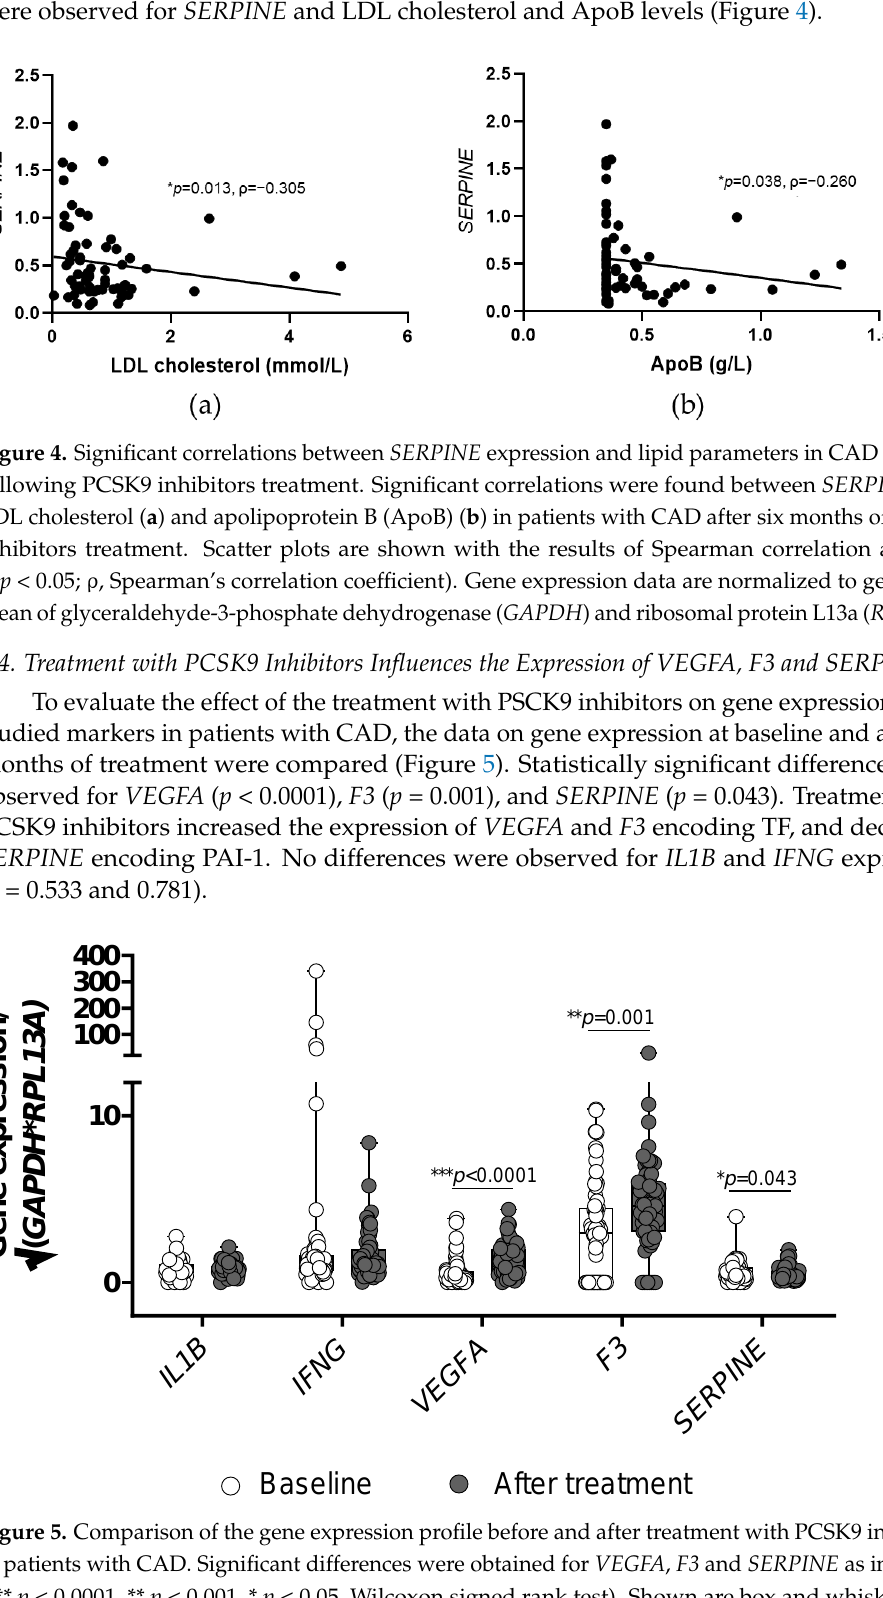
Figure 3. Significant correlations between IL1B expression and lipid parameters. Significant corre- lations were found between IL1B and HDL cholesterol ( a ), triglyceride levels ( b ), and apolipoprotein B (ApoB) ( c ) in healthy controls, and between IL1B and apolipoprotein A1 (ApoA1) ( d ) in patients with CAD prior treatment with PCSK9 inhibitors. Scatter plots are shown with the results of Spear- man correlation analysis (* p < 0.05; ρ , Spearman ’ s correlation coefficient). Gene expression data are normalized to geometric mean of glyceraldehyde-3-phosphate dehydrogenase ( GAPDH ) and ribo- somal protein L13a ( RPL13A ).